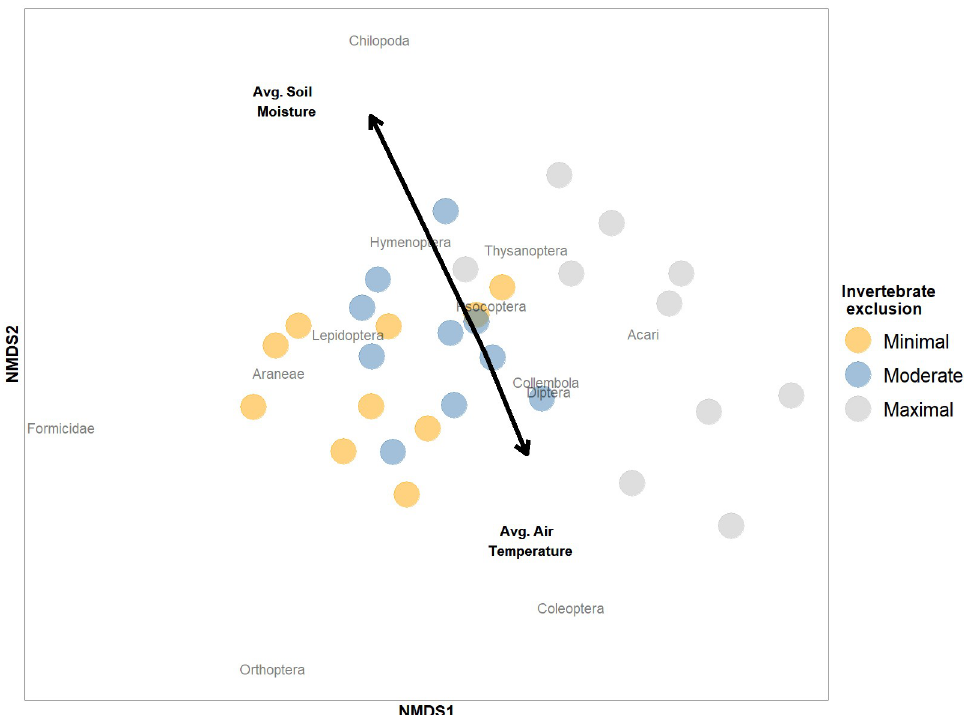
Fig 3. Nonmetric multidimensional scaling (NMDS) plot visualizing the invertebrate community in the litterbags, with invertebrate exclusion treatment separated by color. The communities are aggregated by treatment within chamber ( n = 30). The direction and length of the arrows indicate the relationship between the environmental factors (average air temperature and average soil moisture) and the community matrix. The NMDS stress is 0.20.